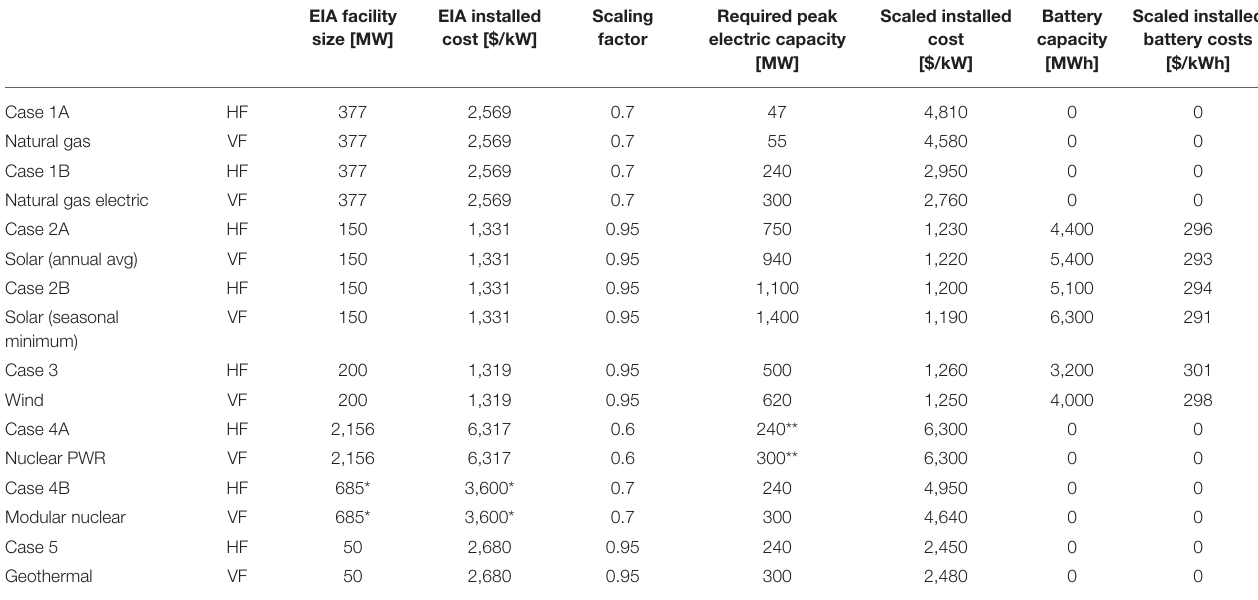
TABLE 3 | Cost information for the energy systems evaluated in this